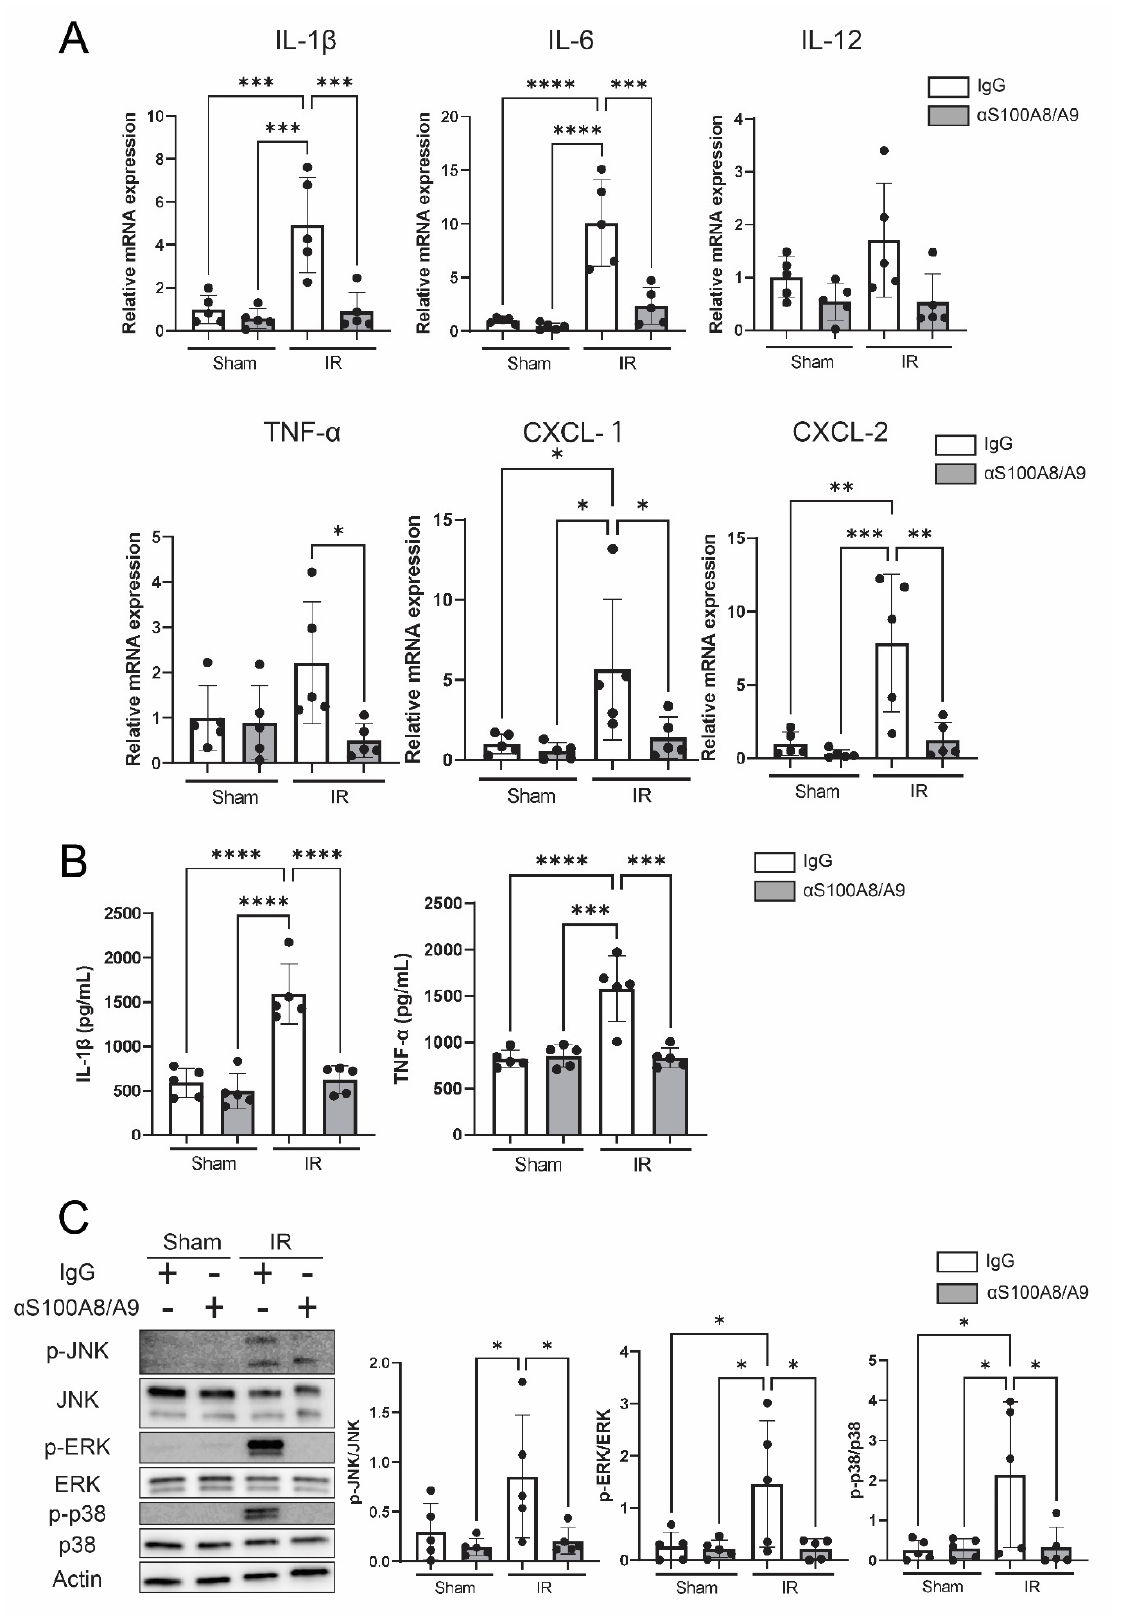
Figure 6. Anti-S100A8/A9 mAb inhibited inflammatory responses in IR injury. ( A ) Relative mRNA expression levels of inflammatory cytokines and chemokines were investigated by qRT-PCR ( n = 5, black ball). ( B ) Protein levels of inflammatory cytokines in the lung were analyzed by ELISA ( n =